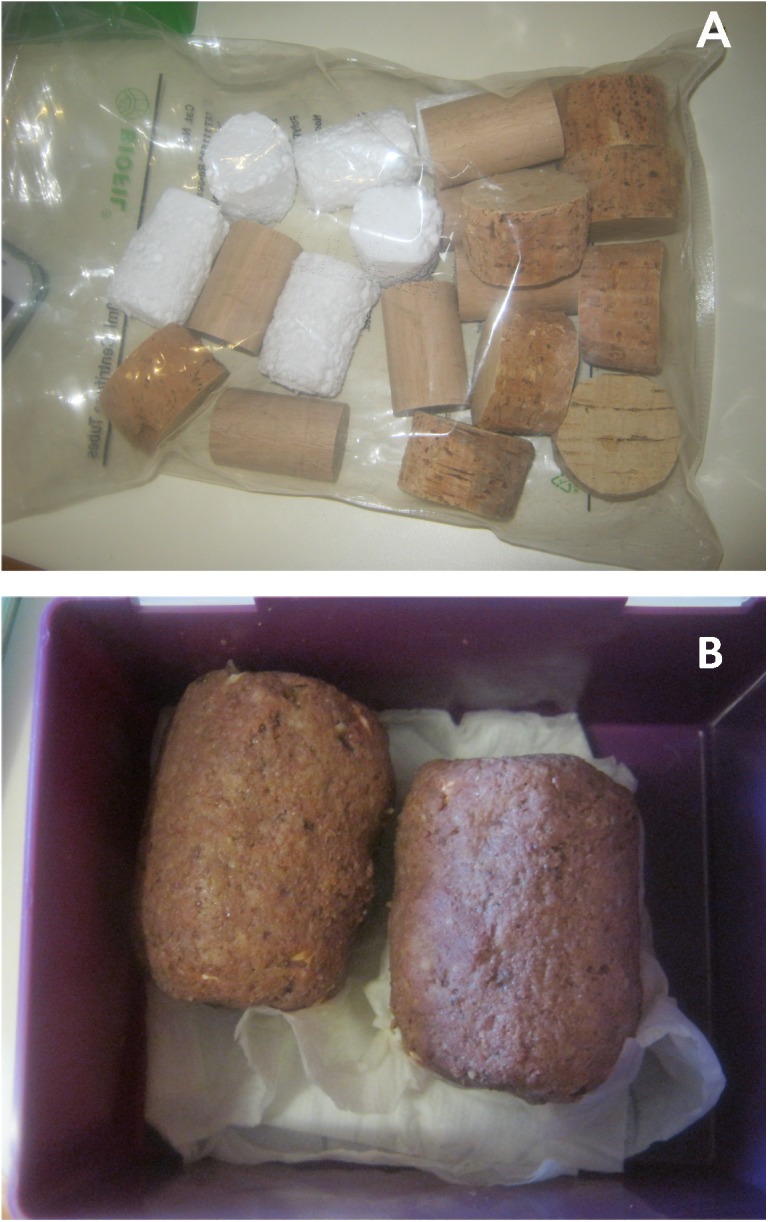
A: Porous substrates (cork, styrofoam, wood) in a bag after sterilization. B: Cork substrates covered with meat, ready for delivery.